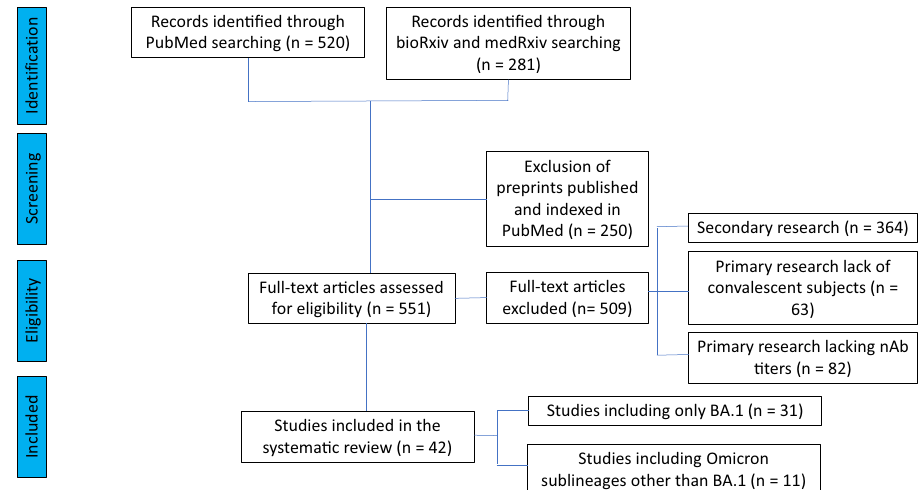
Fig. 1 | PRISMA fl owchart for the current study. Number of records identi fi ed from various sources, excluded by manual screening, found eligible, and included according to subgroup